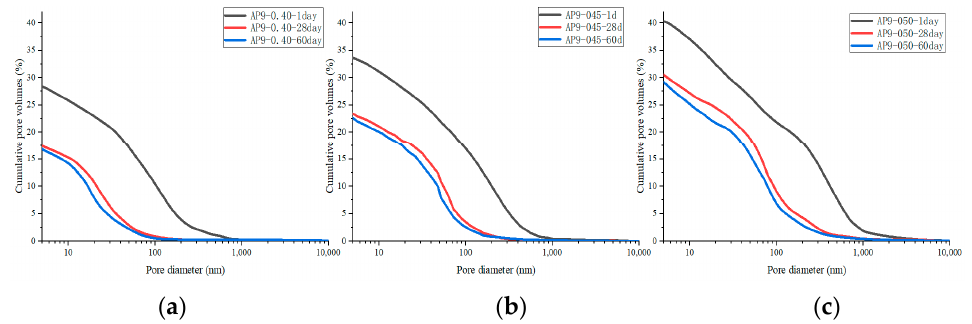
Figure 15. The porosity of hydrated AS-accelerated cement pastes with different w/c: ( a ) PA9-040; ( b ) PA9-045; ( c ) PA9-050.